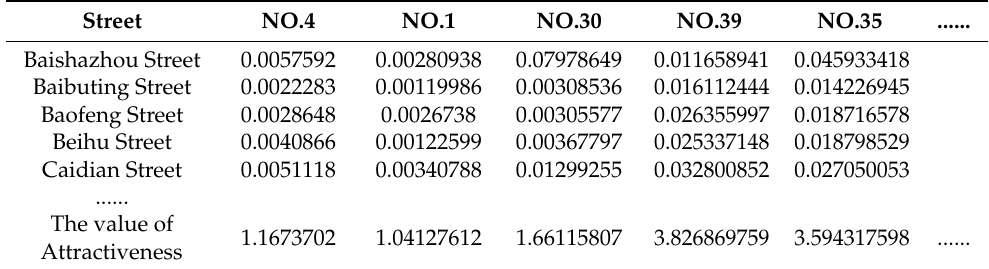
Table 1. Matrix of spatial interaction among streets and commercial